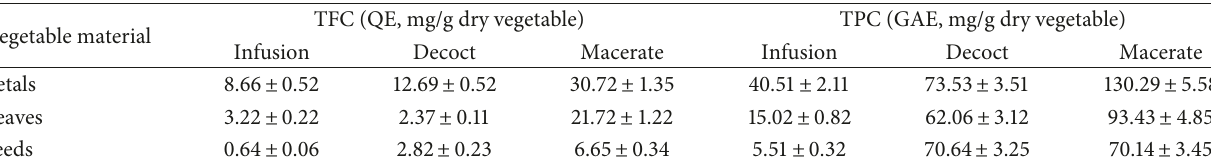
Table 2: Total phenolic content (TPC) and total flavonoid content (TFC) of extracts obtained from different aerial parts of Rudbeckia triloba . Vegetable